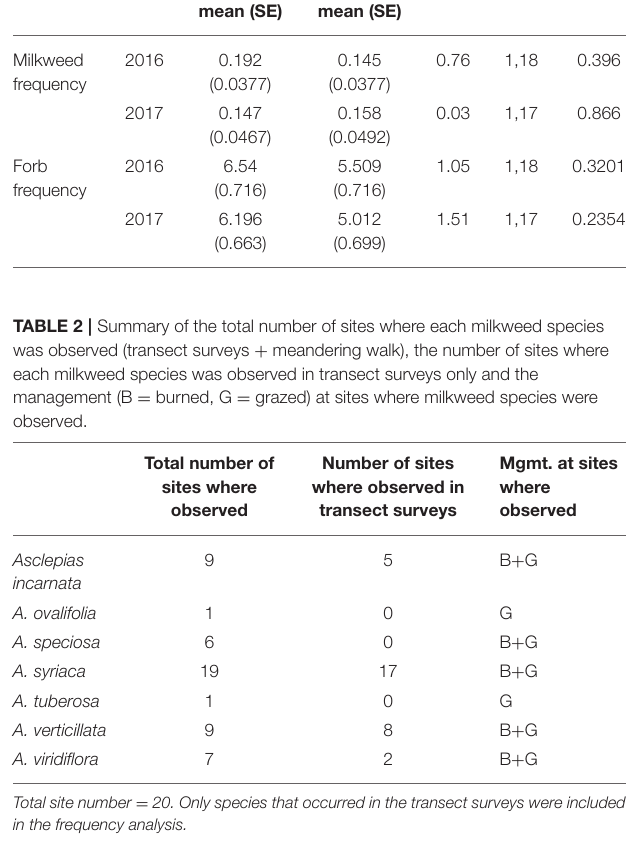
TABLE 1 | Comparison of the frequency of Asclepias and forb species at burned vs. grazed sites in 2016 and 2017. Response